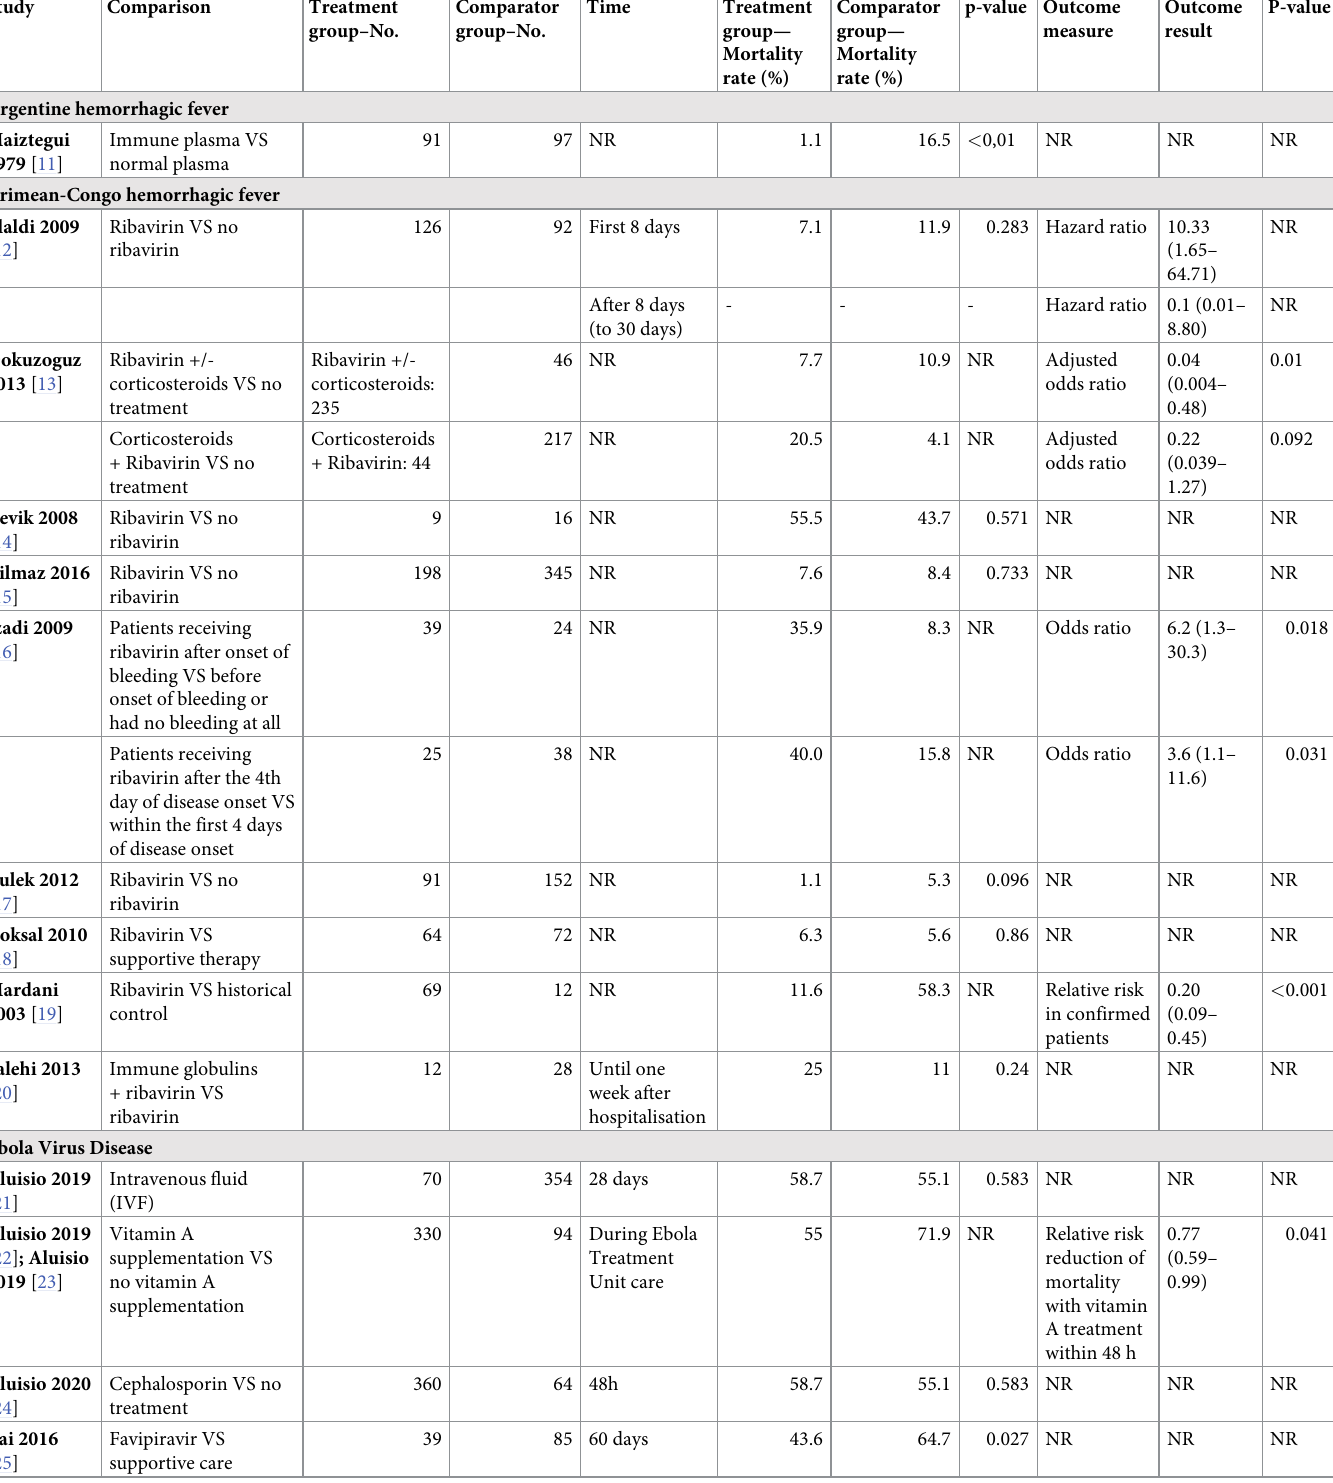
Table 3. Mortality results associated with VHFs treatments reported in the included